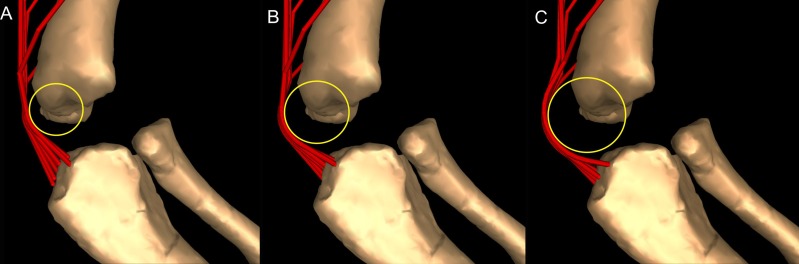
Sensitivity analysis of elbow extensor muscles in Mussaurus patagonicus (right elbow in lateral view; resting pose).Cartilage diameter is shown for (A) reduced by 25% from original, (B) original and (C) enlarged by 25% from original.